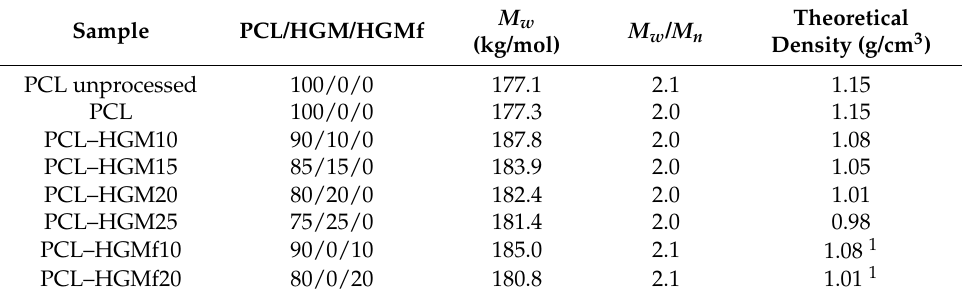
Table 1. Composition by weight and molecular data of the investigated